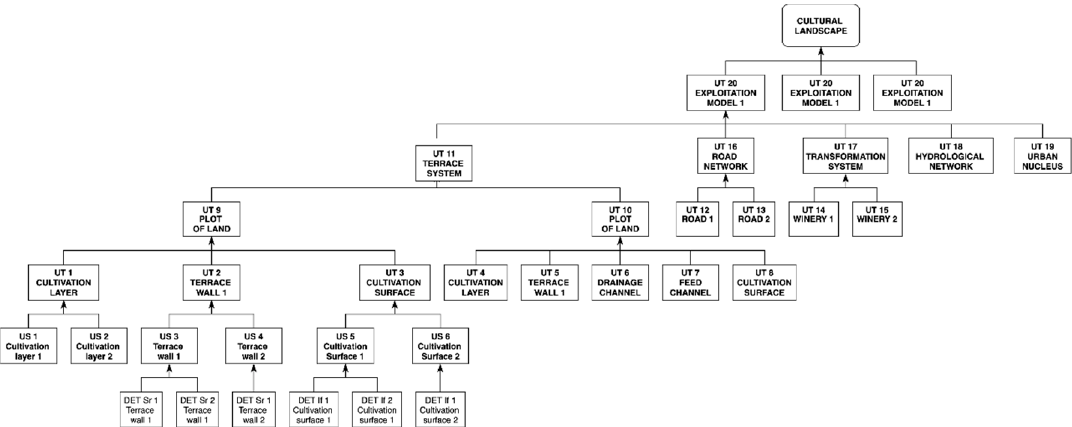
Figure 4. Model of integrated information that illustrates US–UT correlation. Notice that bottom level includes a subclass of US registered as details of the US. Although further thoughts on this will be provided in the discussion section, each row in the graphic represents a same-scale zoom on landscape analysis and how different US are part of the material vestige of a single UT.